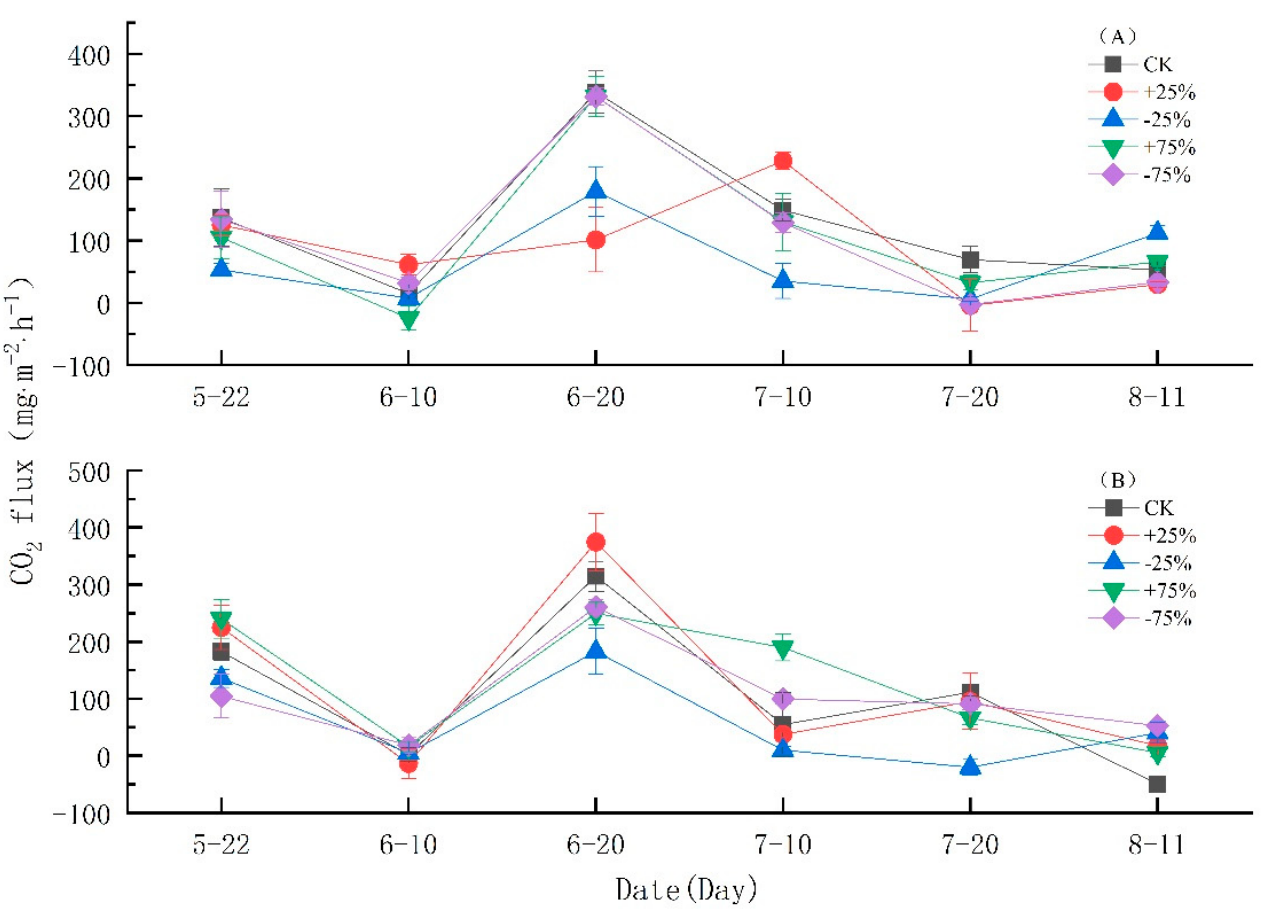
Figure 2. CO 2 emission characteristics during the growing season under different rainfall treatments. Change diagram of the CO 2 emission flux at 11:00 a.m. ( A ). Change diagram of the CO 2 emission flux at 3:00 p.m. ( B ).